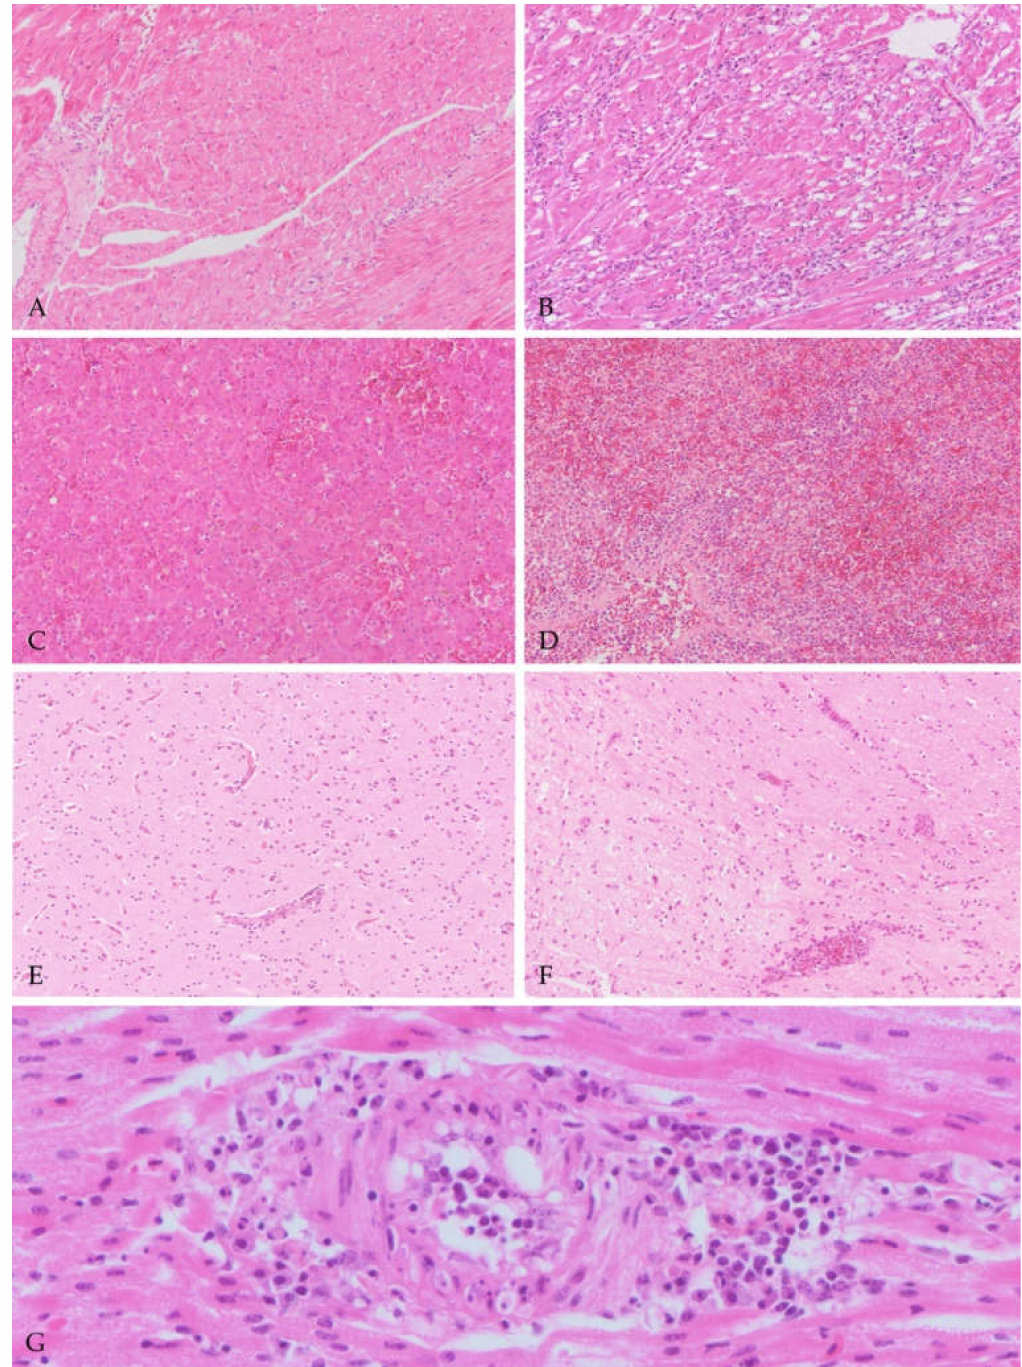
Figure 1. Lesion severity (grades) in different organs and vasculitis in tissues of blackbirds naturally infected with USUV. ( A , B ) Heart (20): mild ( A —Grade 1) and severe ( B —Grade 3) necrosis of cardiomyocytes and inflammation; ( C , D ) liver (20 × ): mild ( C —Grade 1) and severe ( D —Grade 3) necrosis of hepatocytes and inflammation; ( E , F ) cerebrum (20 × ): mild ( E —Grade 1) and severe ( F —Grade 3) degree of inflammation represented as perivascular aggregates of mononucleated cells and in the severe case, also rarefaction of the neuropil; ( G ) vasculitis in a cardiac medium caliber artery (40 × ). Distortion of the vessel wall, with plump and vacuolated endothelial cells, cellular debris and transmural infiltration of inflammatory